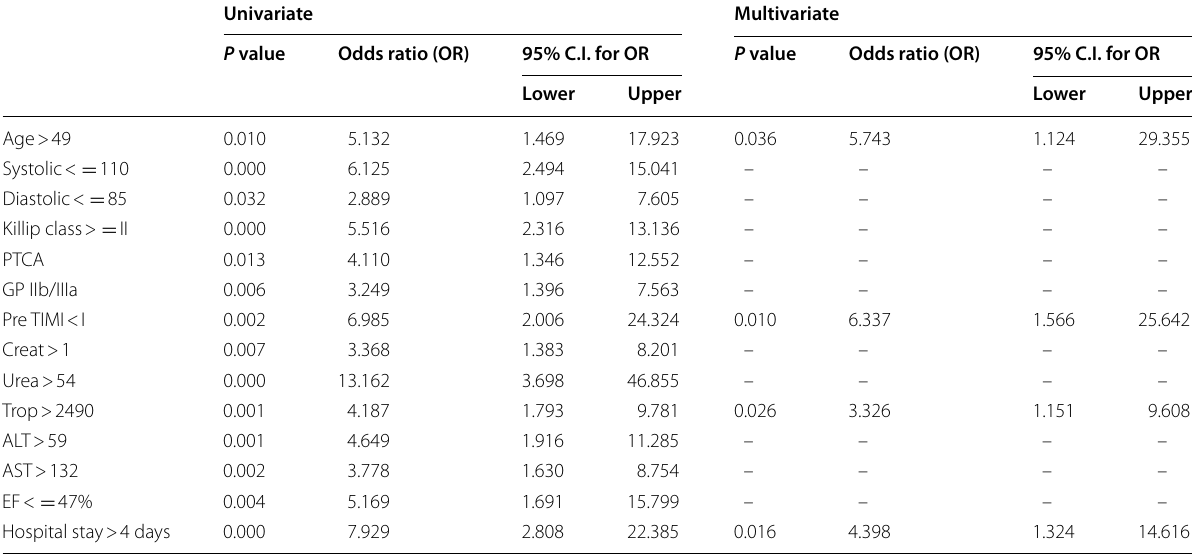
Table 6 Univariate and multivariate by backward Wald logistic regression analysis for factors associated with positive MACE at follow